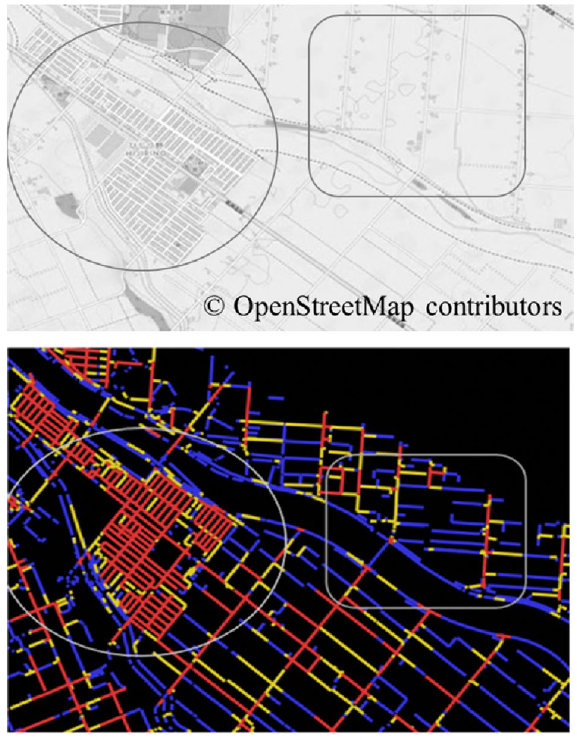
Figure 3. OpenStreetMap (top) and space syntax connectivity map (bottom).